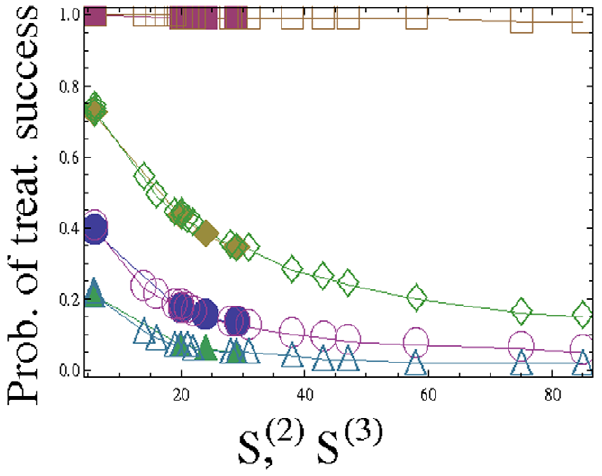
Figure 2. The probability of treatment success as a function of the numbers S ( 2 ) and S ( 3 ) . Different markers correspond to different treatment parameters: circles (division rate L=10 , death rate d=9 , drug-induced death rate h i =10 , mutation rate u=10 2 7 , cancerous population size at the start of treatment N = 10 10 ), squares ( L ~ 1, d ~ 0, h i ~ 10, u ~ 10 { 8 , N ~ 10 11 ), diamonds ( L ~ 5, d ~ 4, h i ~ 10, u ~ 10 { 8 , N ~ 10 12 ), triangles ( L ~ 5, d ~ 4, h i ~ 10, u ~ 10 { 8 , N ~ 10 13 ). Empty markers denote three-drug treatments, and solid ones – two- drug treatments. The data are presented in tables 5 and 6.